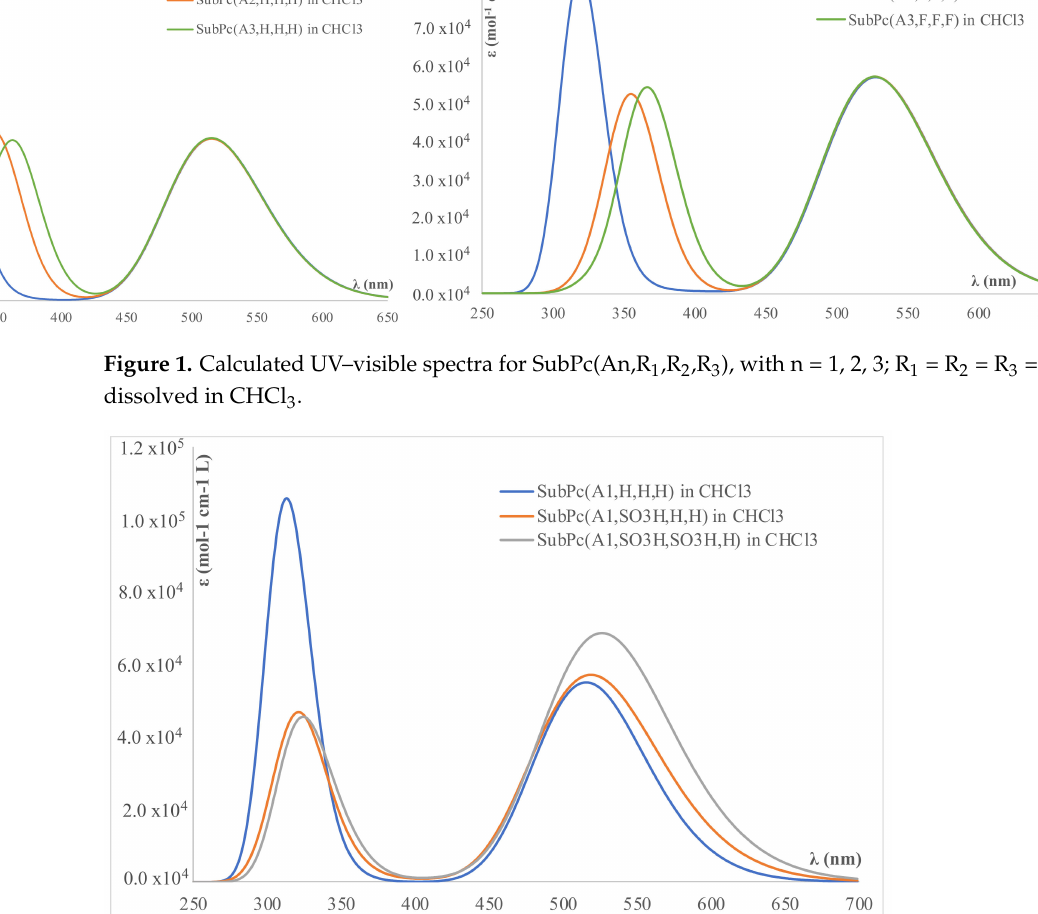
Figure 2. Calculated UV–visible spectra for SubPc(A1,R 1 ,R 2 ,R 3 ) with R 1 = R 2 = R 3 = H; R 1 = SO 2 H, R 2 = R 3 = H; R 1 = R 2 = SO 2 H, R 3 = H, dissolved in CHCl 3